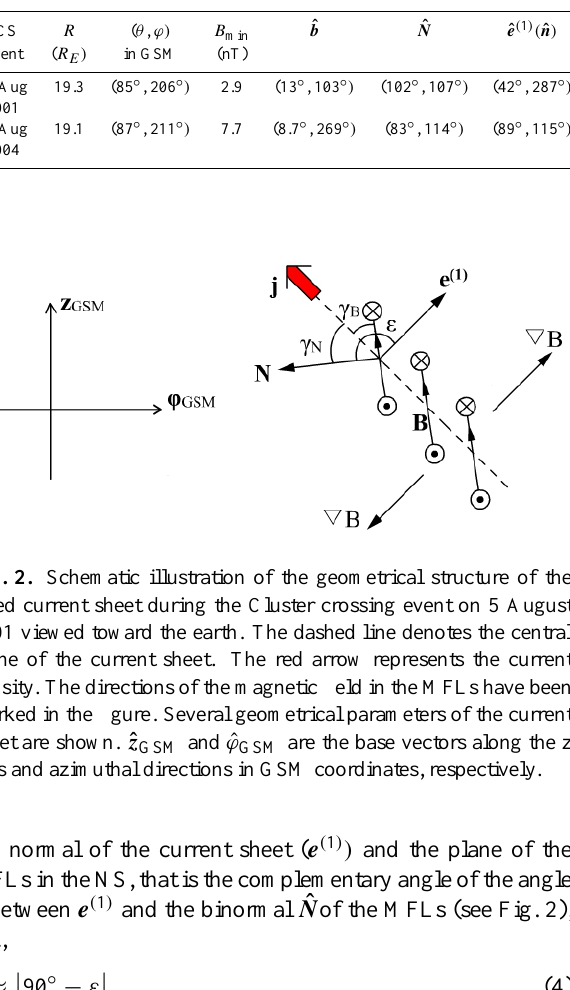
Table 1. The parameters in the center of the NS of the two TCS.